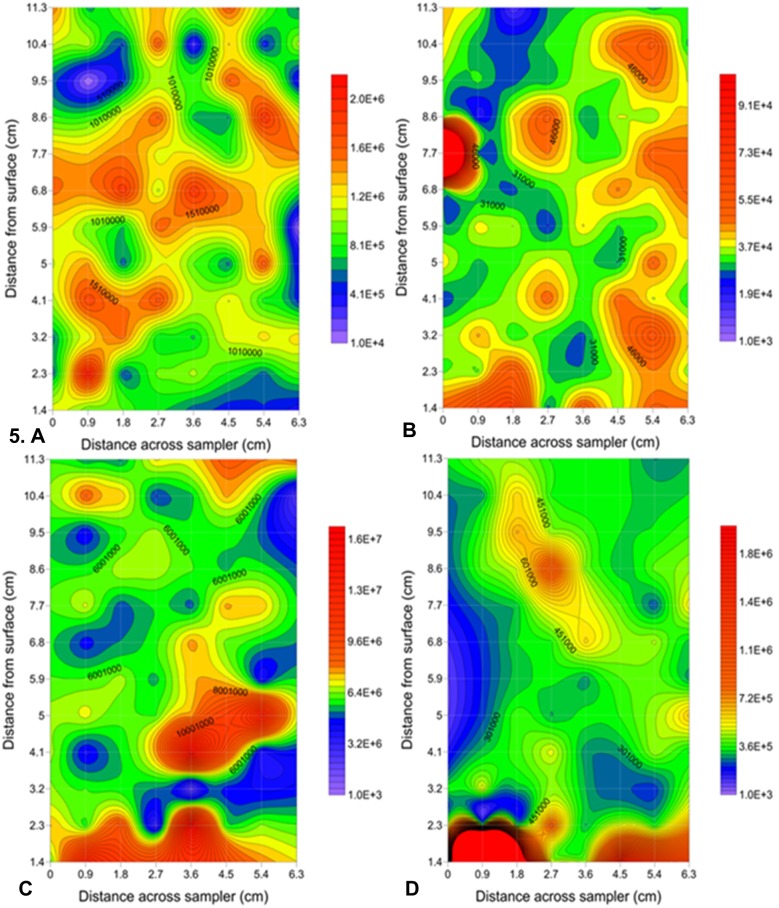
Two-dimensional contour plots showing the highest change in heterogeneity due to the presence of hotspots and coldspots within bacterial and viral subpopulations.Hotspots and coldspots seen across a distance of 6.3×11.3 cm using Surfer 10 (Golden Software, Inc.). Noarlunga: A VLP 2 showing a 2585-fold change in abundance over 0.9 cm. B LDNA showing a 12.9-fold change in abundance over 0.9 cm. St Kilda: C VLP 1 showing a maximum 10.52-fold change in heterogeneity seen over 0.9 cm. D HDNA 2 showing a maximum 45.2-fold change in heterogeneity seen over 0.9 cm. There were a range of heterogeneities over 0.9 cm (Fig. S4) indicating a variety of intensities for hotspots and coldspots. Abundance levels are indicated by a colour intensity scale in units of cells/particles ml−1. Solid red circles indicate areas of abundance higher than the maximum contour level selected. A minimum contour interval value of at least 1000 was chosen based on maximum machine error. The faint gridlines show sample interval.